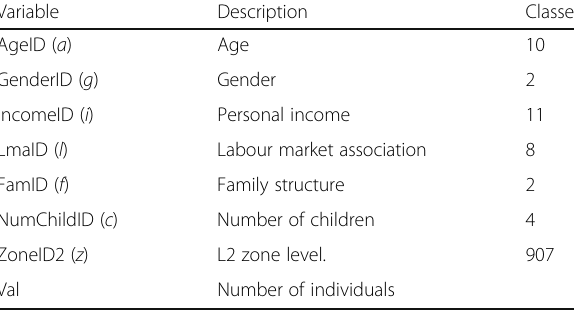
Table 3 Structure of starting solution and final master